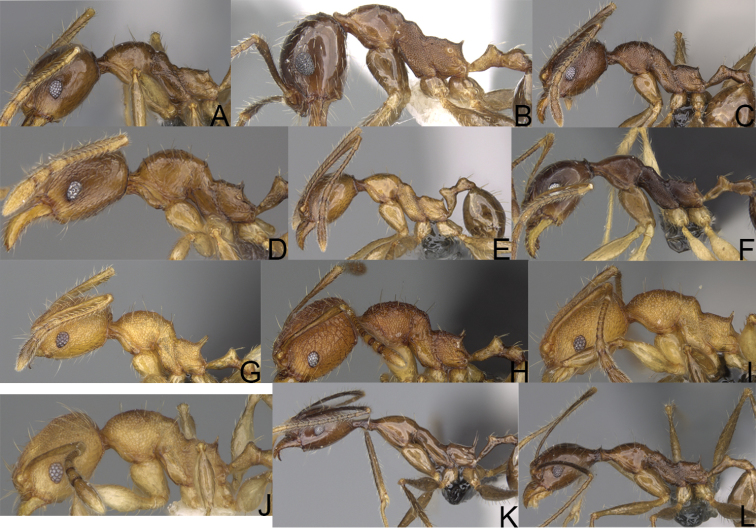
Pheidole
cf.
madecassa minor worker, profile (A). Pheidole
indica Mayr minor worker, profile (B). Pheidole
veteratrix Forel minor worker, profile (C). Pheidole
cf.
veteratrix minor worker, profile (D). Pheidole
cf.
bessonii minor worker, profile (E). Pheidole
bessonii Forel minor worker, profile (F). Pheidole
vahamarensis sp. nov. minor worker, profile (G). Pheidole
curvistriata sp. nov. minor worker, profile (H). Pheidole
mavesatra sp. nov. minor worker, profile (I). Pheidole
rugocephala sp. nov. minor worker, profile (J). Pheidole
grallatrix Forel minor worker, profile (K). Pheidole
cf.
grallatrix minor worker, profile (L).